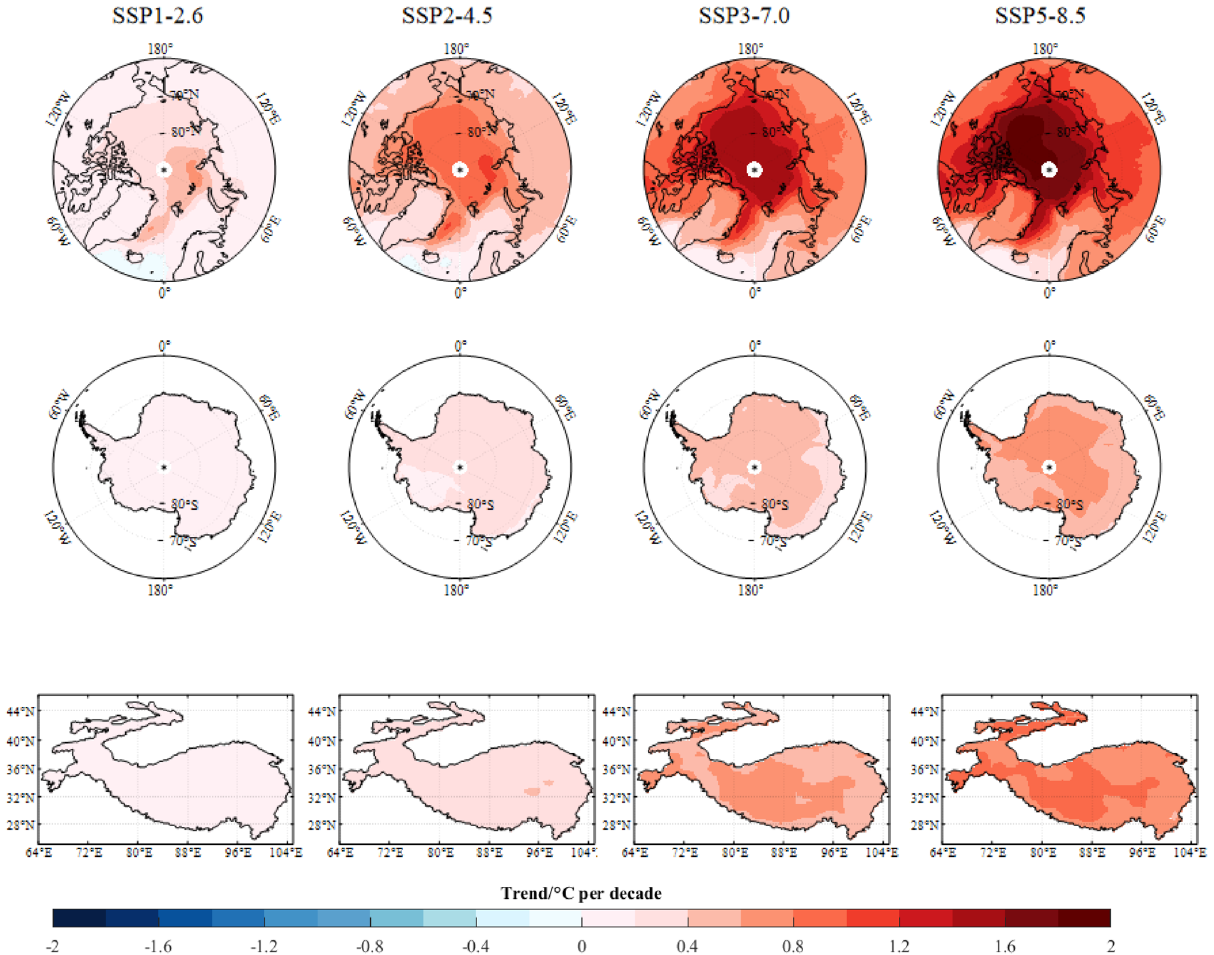
Figure 5. Spatial patterns of annual temperature trend over the Arctic, Antarctica and The Third Pole from the multi-model ensemble mean (MMEM) of the CMIP6 simulations under different SSPs during 2015–2100. The grey dotted region represents that the trend is not significant. The map was drawn in the software MATLAB R2018b (https:// ww2. mathw orks. cn/ produ cts/ matlab.